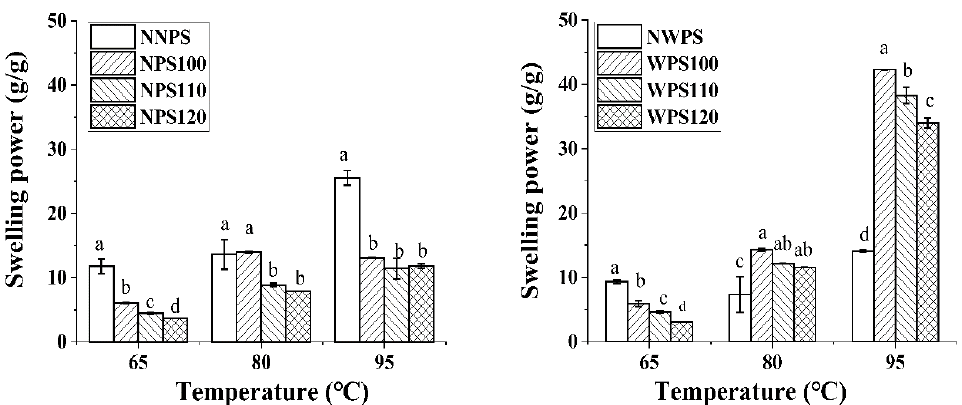
Figure 3. The swelling power of the samples. Different letters in a histogram signify significant differences ( p < 0.05).